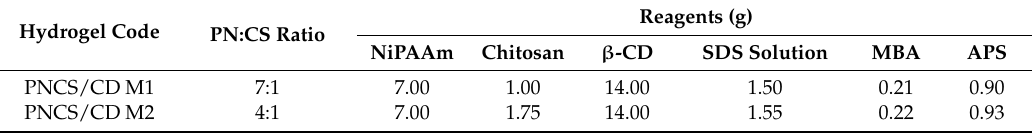
Table 1. Synthesis reagents used for the preparation of the PNCS and PNCS/CD